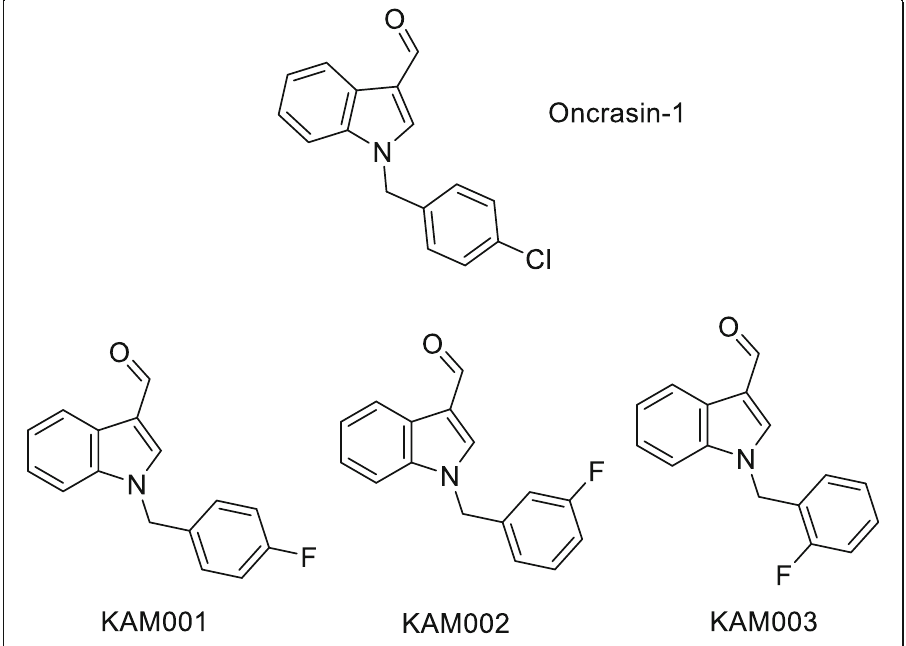
Fig. 1 Parental compound, Oncrasin-1, and 3 fluorinated derivatives